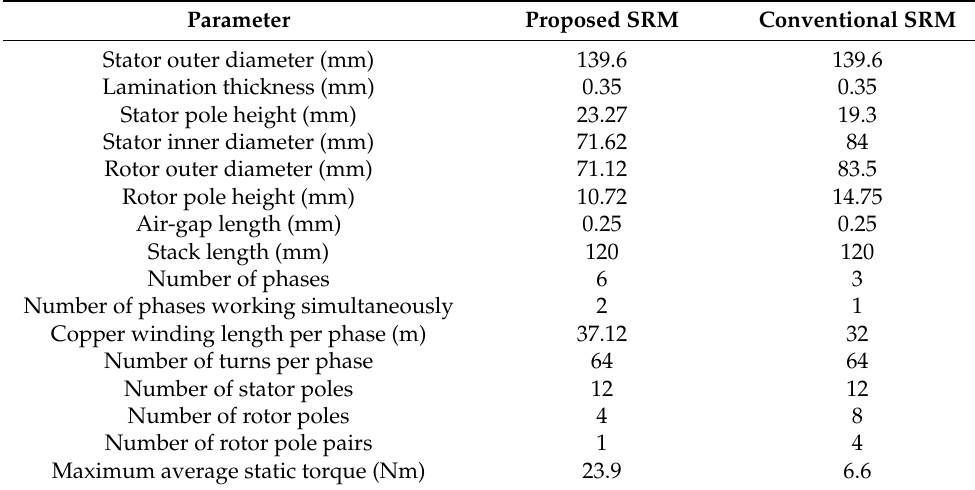
Table 1. Parameters of the proposed SRM and the conventional SRM.